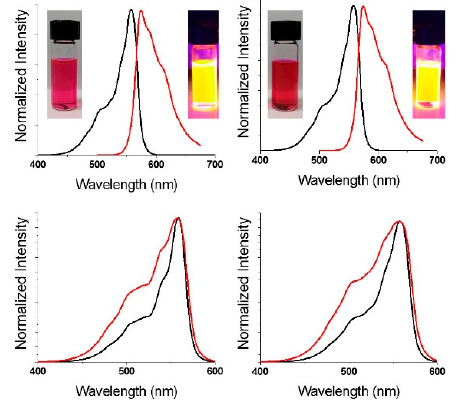
Figure 3. Normalized absorbance ( black ), emission ( λ ex = 325 nm ( red; upper )) and excitation ( λ em = 625 nm ( red; lower )) spectra of C 3 ( left ) and C 1 ( right ) F 3 -SPcs. Samples in THF solution.